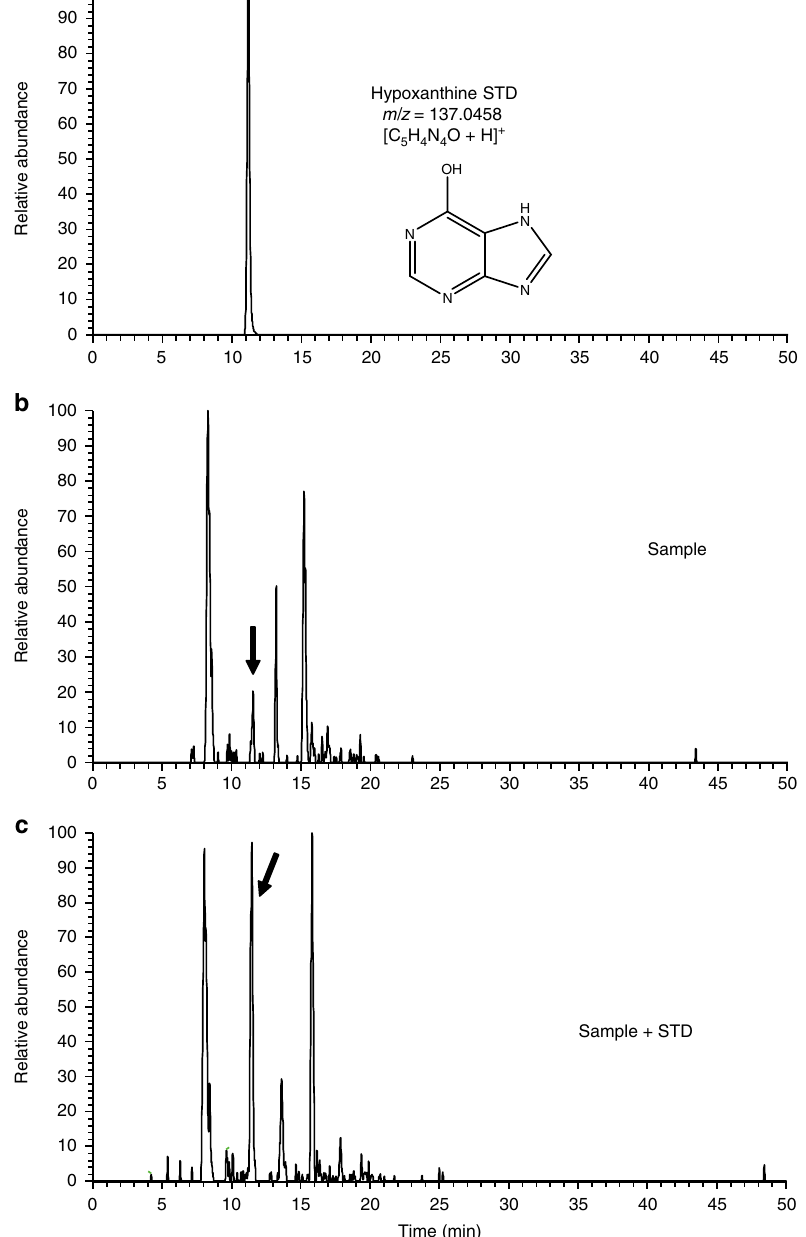
Fig. 3 Identi fi cation of hypoxanthine in the organic residues. Mass chromatograms of a the hypoxanthine standard, b the analyte sample and c the co- injected mixture of hypoxanthine standard and analyte sample at a mass-to-charge ratio ( m/z ) of 137.0458. A C18 separation column was used for the analysis by HPLC/HRMS. The solid arrow indicates the presence of hypoxanthine. The intensity of the peak at ~11.3 min, which is associated with hypoxanthine (panel a ), is higher in the co-injected sample (panel c ) than in the analyte-only sample (panel b